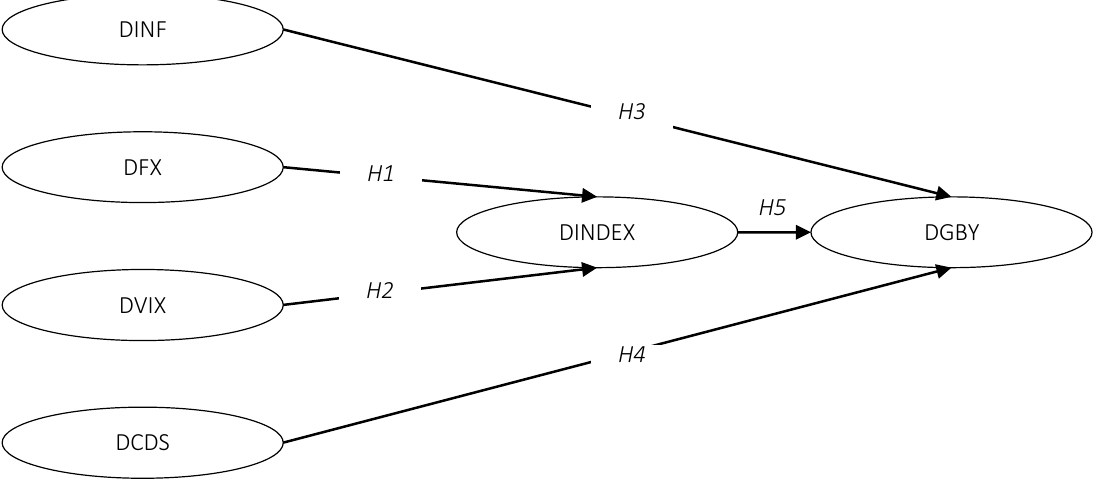
Figure 3. Research model framework